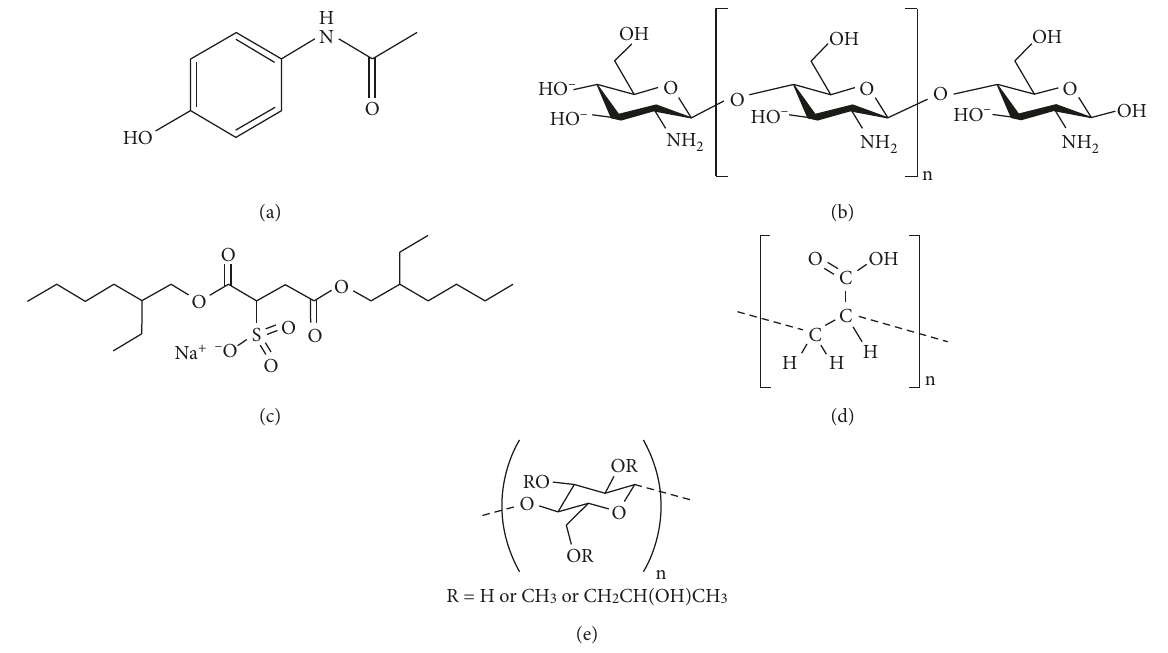
Figure 1: Molecular structures of (a) APAP, (b) CS, (c) AOT, (d) PAA, and (e)